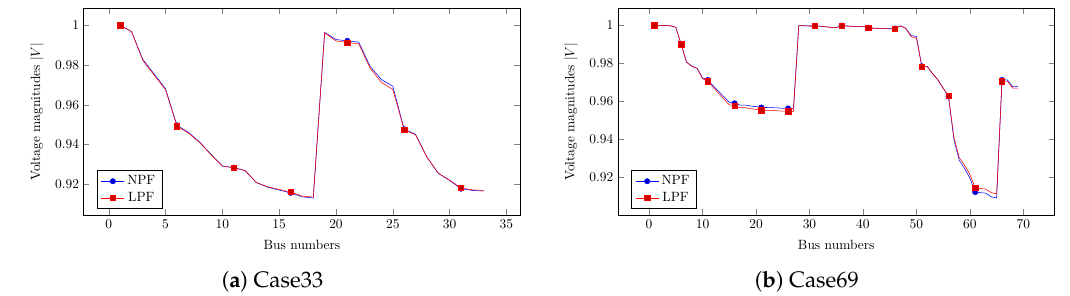
Figure 3. Comparison of NPF and LPF computations for voltage magnitudes of all buses in two test networks Case33 and